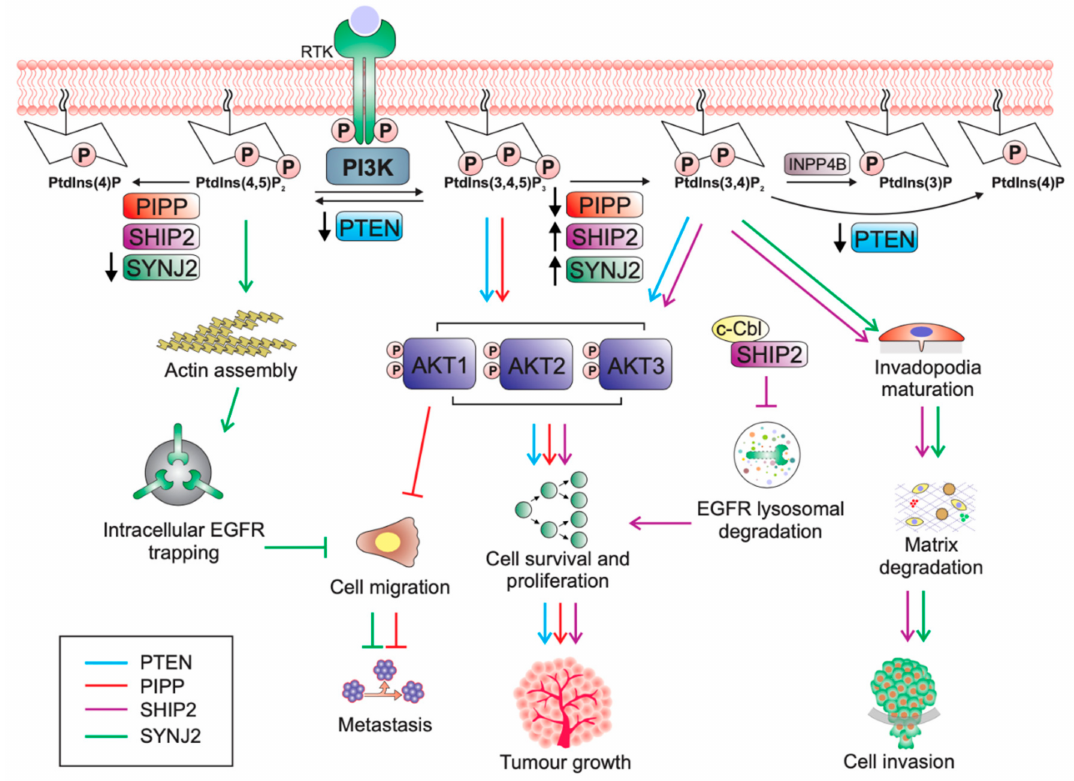
Figure 1. Pro- and anti-tumourigenic e ff ects of PTEN and the 5-phosphatases in breast cancer. Class I PI3K phosphorylates PtdIns(4,5)P 2 to form PtdIns(3,4,5)P 3 at the plasma membrane in response to growth factor binding to a receptor tyrosine kinase (RTK). PtdIns(3,4,5)P 3 facilitates activation of PH domain containing proteins such as AKT to regulate cell survival, proliferation and migration. PTEN negatively regulates PI3K / AKT signalling by dephosphorylating PtdIns(3,4,5)P 3 and PtdIns(3,4)P 2 to form PtdIns(4,5)P 2 and PtdIns(4)P, respectively. Alternatively, PtdIns(3,4,5)P 3 can be hydrolysed by the 5-phosphatases including PIPP, SHIP2 and SYNJ2 to produce PtdIns(3,4)P 2 , a phosphoinositide which also binds AKT. PtdIns(3,4)P 2 is further dephosphorylated by the 4-phosphatases such as INPP4B to terminate AKT signalling. PTEN is a bona fide tumour suppressor and PTEN loss promotes mammary tumour initiation and growth through PtdIns(3,4,5)P 3 and PtdIns(3,4)P 2 -mediated AKT activation (blue arrows). Similarly, PIPP is anti-tumourigenic and loss of PIPP increases PtdIns(3,4,5)P 3 and AKT activation, enhancing cell survival and proliferation, and facilitating tumour growth (red arrows). Paradoxically, PIPP depletion inhibits cell migration and metastasis through AKT1 (red arrows). Despite being negative regulators of the PI3K / AKT signalling axis, SHIP2 and SYNJ2 are pro-tumourigenic. Increased SHIP2 expression promotes cell survival, proliferation and tumour growth through PtdIns(3,4)P 2 -mediated AKT activation, as well as via inhibition of c-Cbl-mediated EGFR degradation (magenta arrows). SHIP2 and SYNJ2 also enhance tumour cell invasion by increasing localised PtdIns(3,4)P 2 levels at the invadopodia core, promoting invadopodia maturation and matrix degradation (SHIP2 magenta arrows; SYNJ2 green arrows). SYNJ2 depletion promotes PtdIns(4,5)P 2 -mediated accumulation of F-actin on intracellular vesicles, leading to impaired EGFR recycling and EGF-dependent migration (green